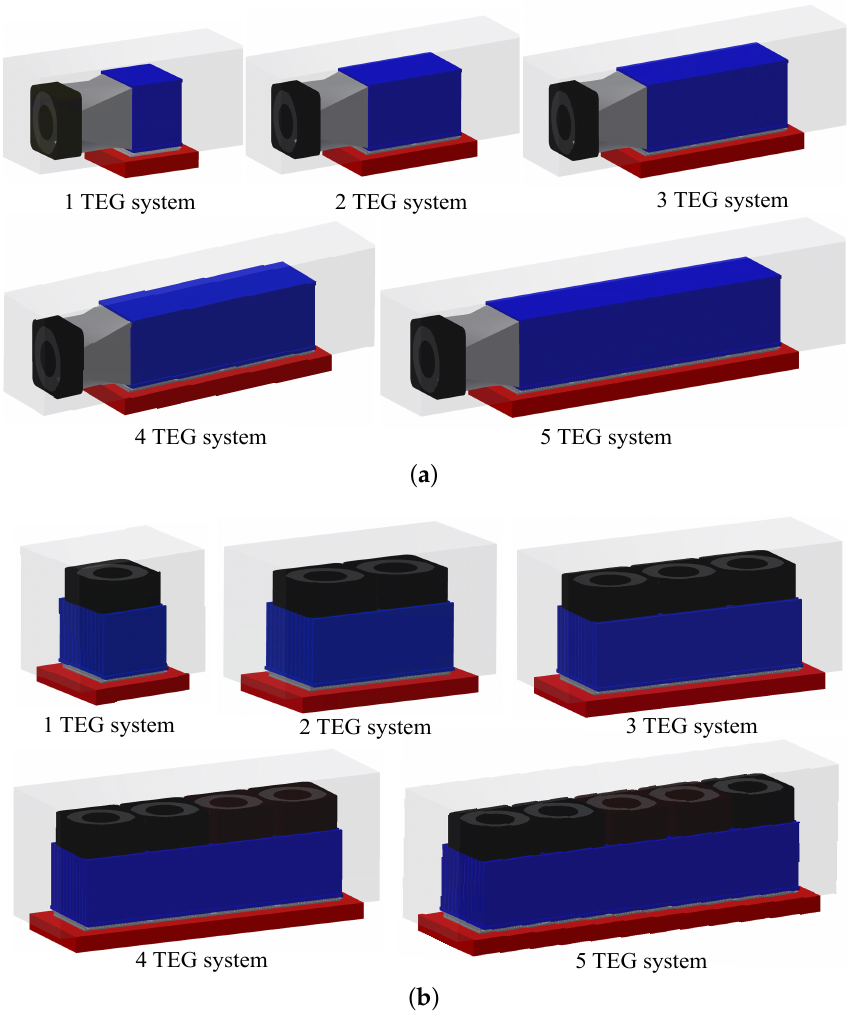
Figure 7. SMF and TMF systems; ( a ) SMF-TEG systems (Proposed system) and ( b ) TMF-TEG